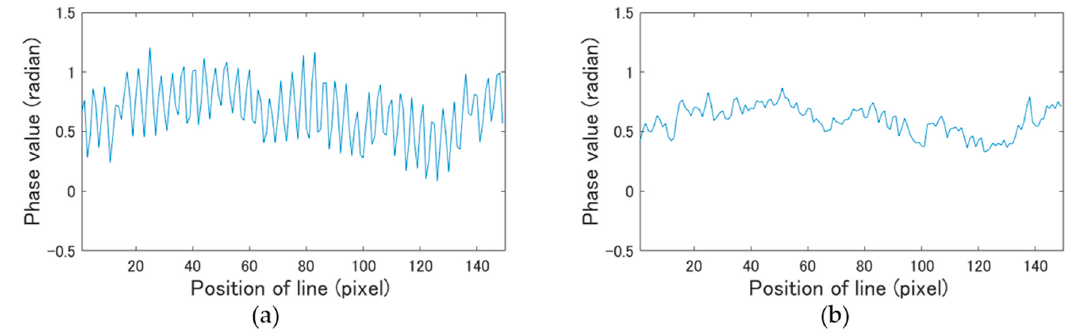
Figure 10. The phase values of the dotted red line in Figure 9b,d. ( a ) Conventional method. ( b ) Proposed method.